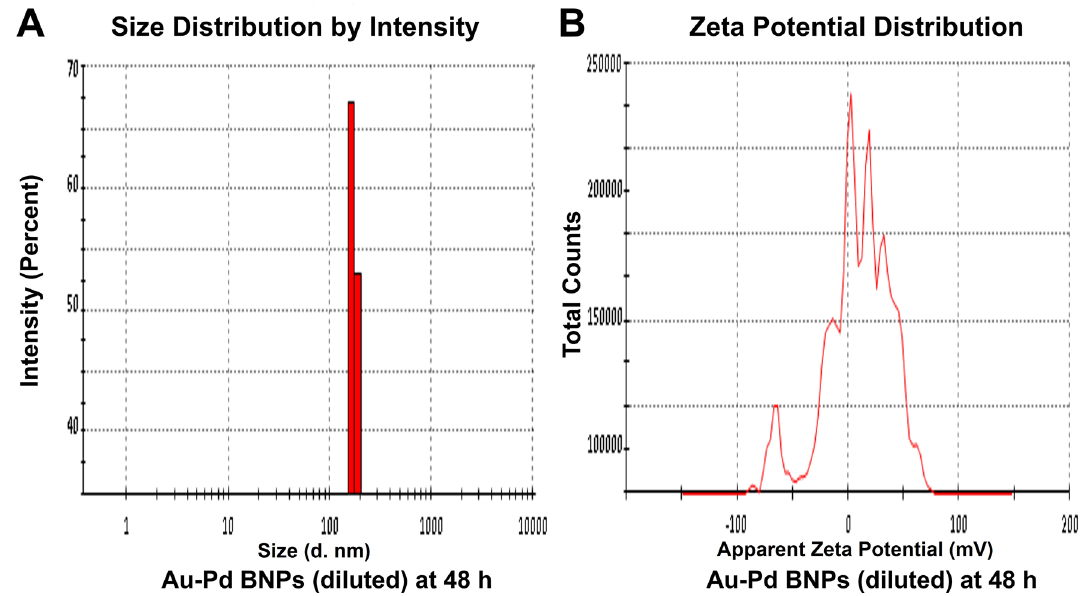
Figure 7. ( A ) DLS analysis and ( B ) Zeta Potential analysis, of the diluted (1:10) sample of 2 mM synthesized Au–Pd BNPs using 10% aqueous leaf extract of the plant Citrus limon at 48 h of synthesis.